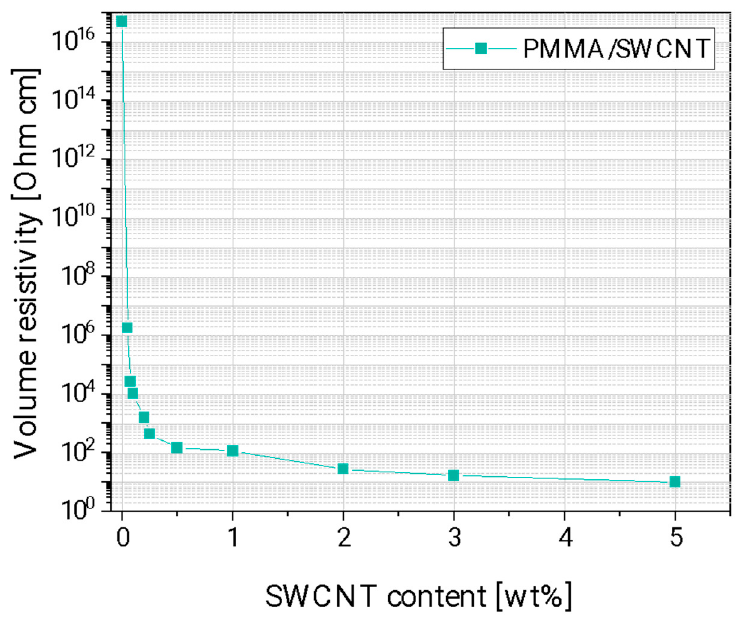
Figure 4. Electrical volume resistivity of PMMA/SWCNT composites prepared with direct incorporation method at 250 rpm.